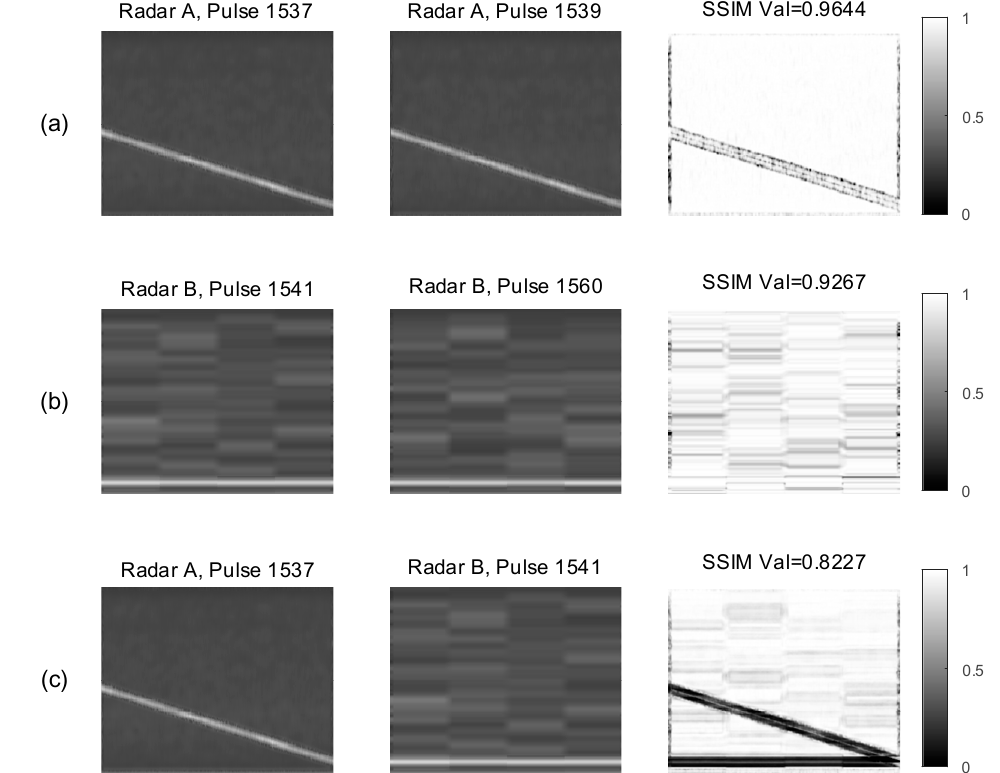
Figure 2. Comparison of SSIM between time-frequency images: ( a ) pulses are from radar A; ( b ) pulses are from radar B; ( c ) pulses are from different radars. Among them, pulse 1537 and pulse 1539, pulse 1541 and pulse 1560 come